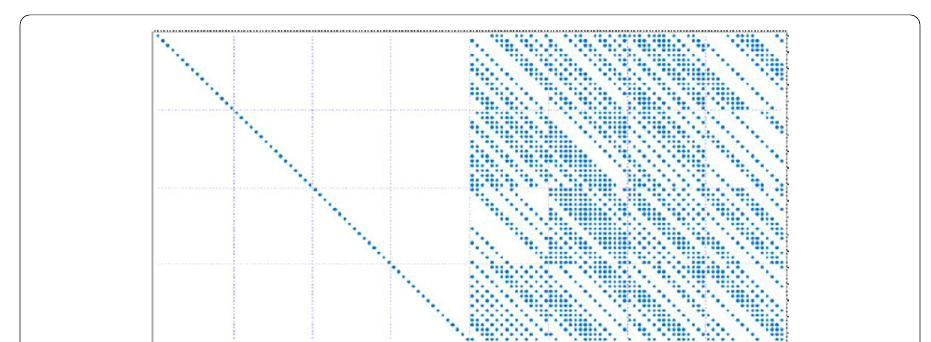
Fig. 9 Scatter chart for the generator matrix G of the LDPC(128, 64)